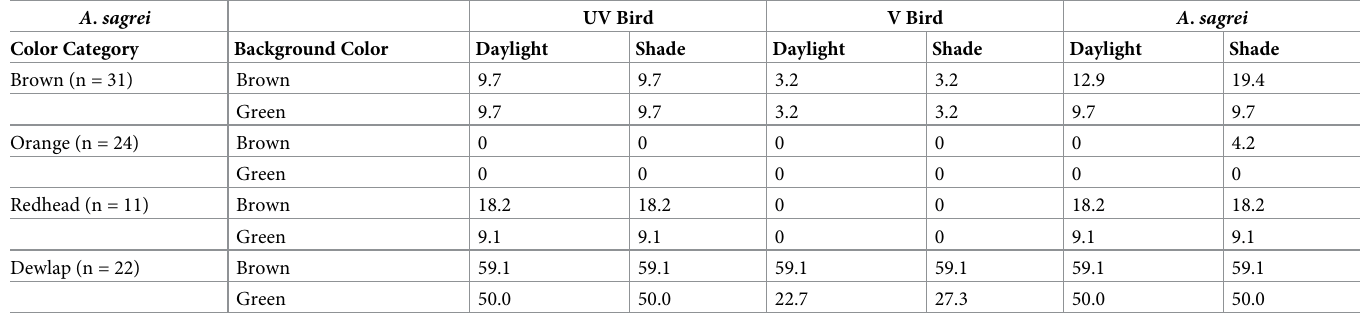
ble than or as discriminable as brown lizards.